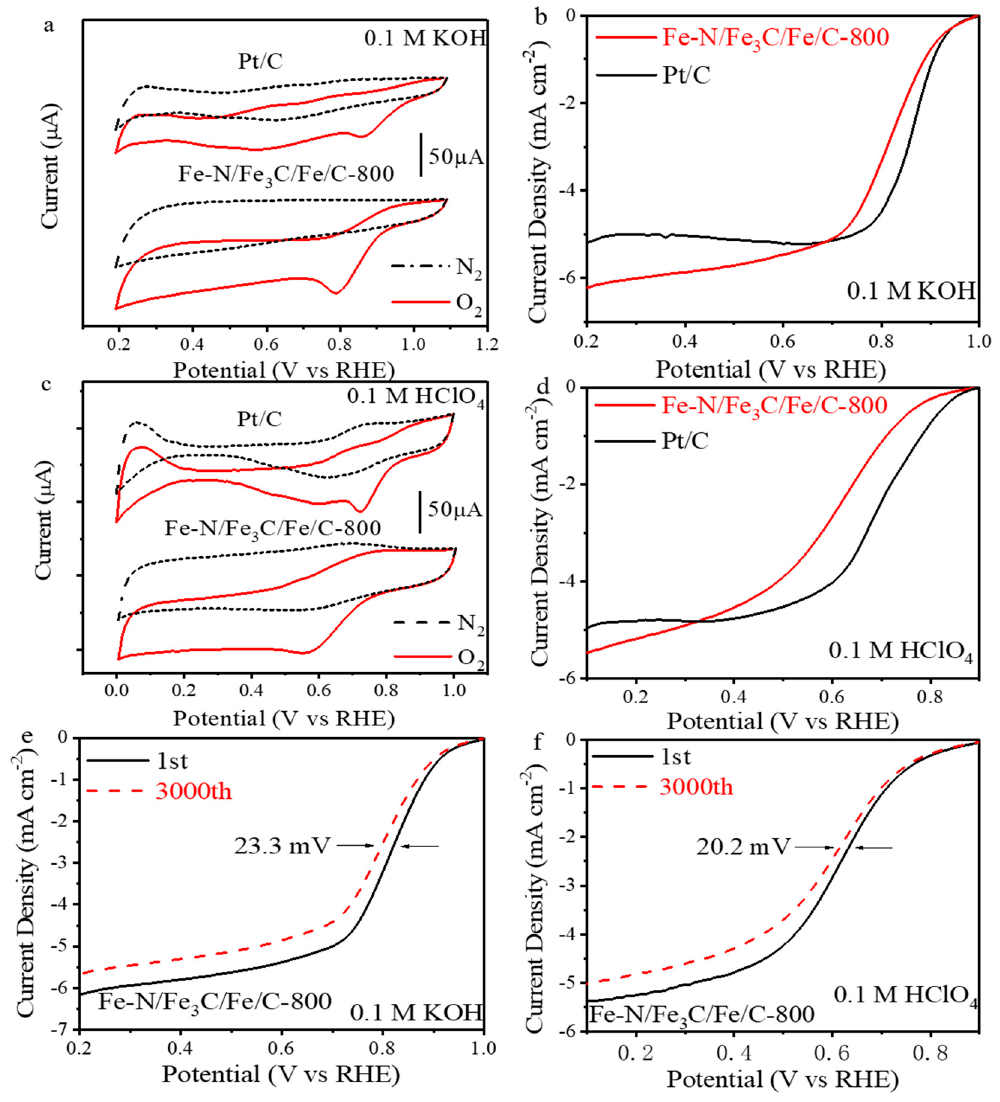
Figure 3. ( a ) Cyclic voltammograms of Pt/C and Fe-N/Fe 3 C/Fe/C-800 in 0.1 M KOH; ( b ) Oxygen reduction reaction (ORR) polarization curves of Pt/C and Fe-N/Fe 3 C/Fe/C-800 in 0.1 M KOH; ( c ) cyclic voltammograms of Pt/C and Fe-N/Fe 3 C/Fe/C-800 in 0.1 M HClO 4 ; ( d ) ORR polarization curves of Pt/C and Fe-N/Fe 3 C/Fe/C-800 in 0.1 M HClO 4 ; ( e , f ) endurance test of Fe-N/Fe 3 C/Fe/C-800 for 3000 cycles in O 2 -saturated KOH and HClO 4 (0.1 M) (Scanning rate: 10 mV/s, rotating).